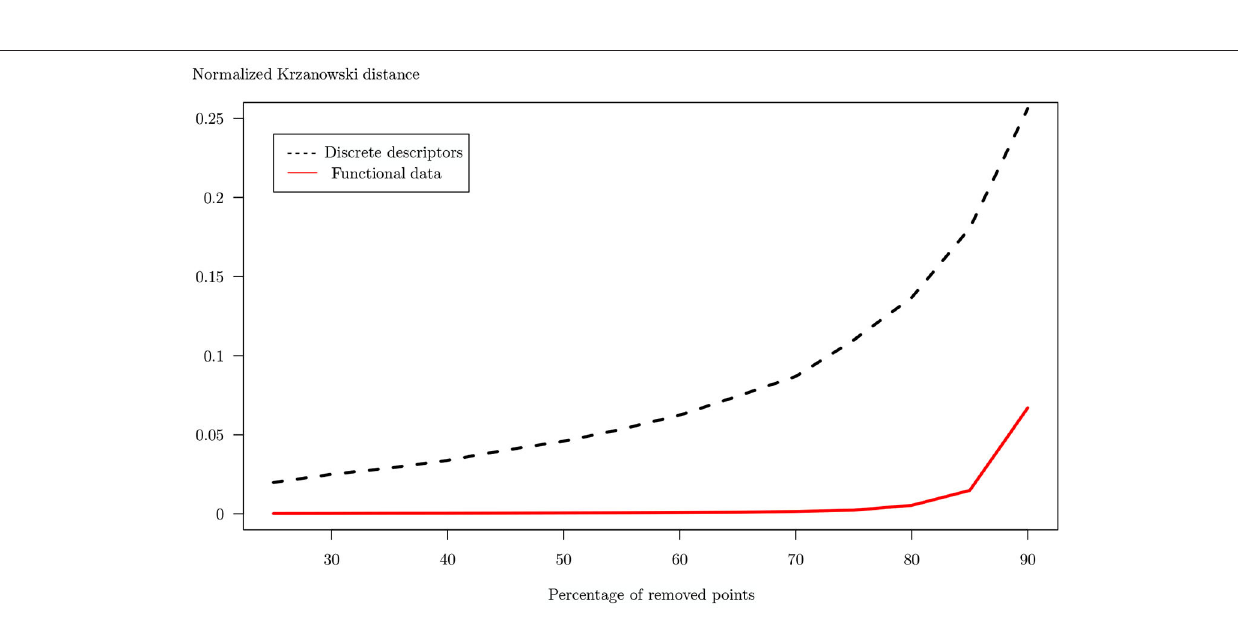
FIGURE 11 | Krzanowski distance calculated between reference PCA of raw dives and PCAs of downsampled dives in functional case (red line) and using classic descriptors (black dotted line). Each raw dive has been downsampled by removing a percentage of points ranging from 20 to 90 % by 5 % . Both distances have been normalized for the ease of